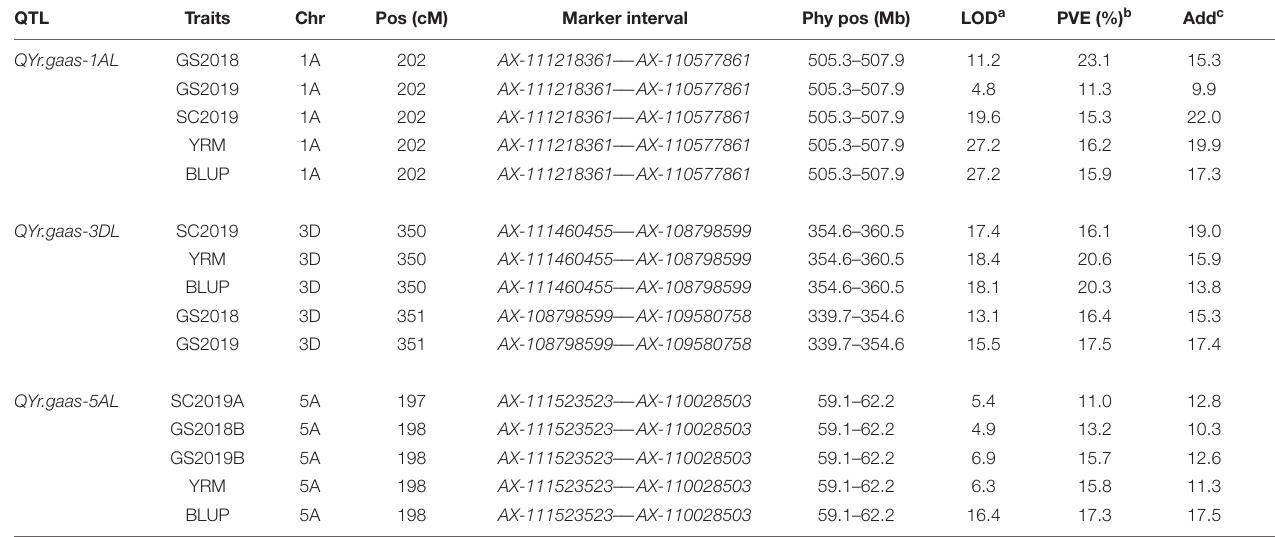
TABLE 3 | Position and effect of quantitative trait loci (QTL) that were detected for adult plant resistance (APR) to stripe rust (YR) in the test years, using each final disease severity, the mean of final disease severity (MFDS), best linear unbiased prediction (BLUP) for the Huixianhong/Pascal RIL population. QTL Traits Chr Pos (cM) Marker interval Phy pos (Mb) LOD a PVE (%) b Add